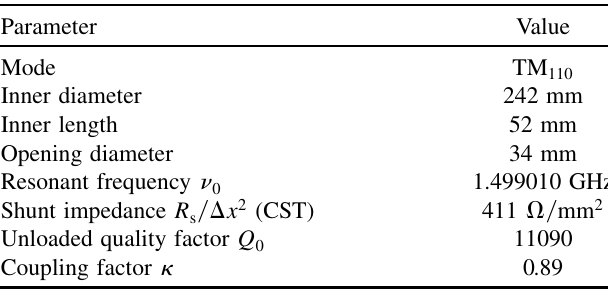
TABLE II. Parameters of the x -position cavity.